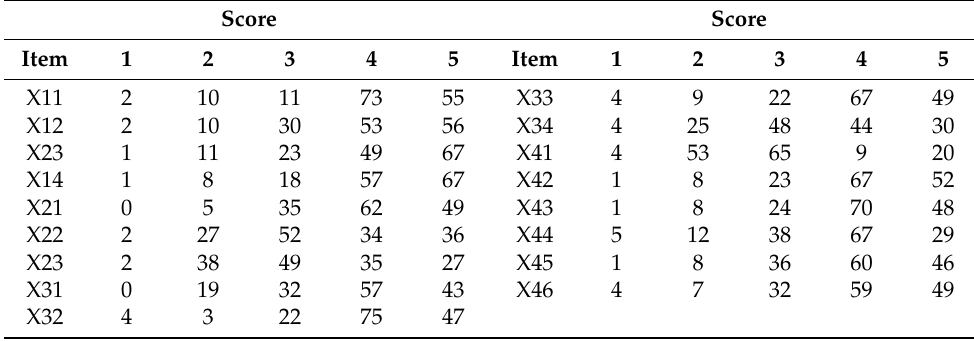
Table 3. Summary of the results of the questionnaire